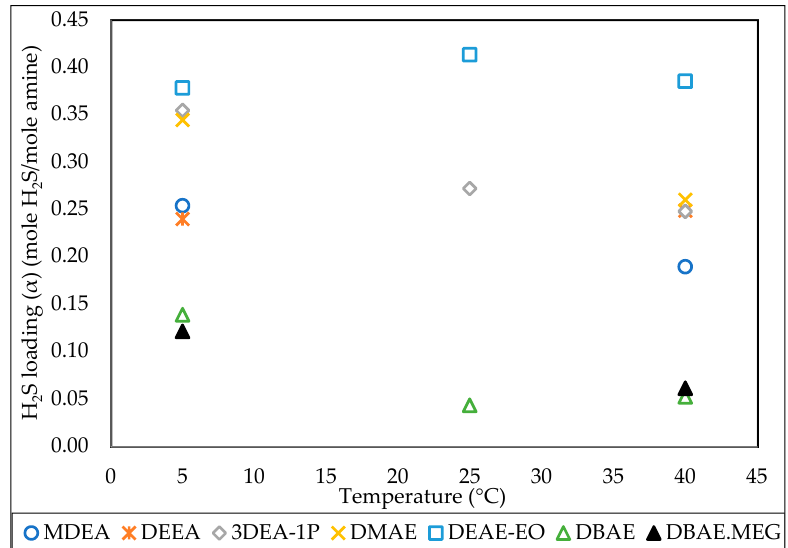
Figure 8. Effect of temperature on H 2 S loading; pH 2 S = 1 kPa; amine concentration = 20 wt.% (unloaded); DBAE solutions makes two phases.